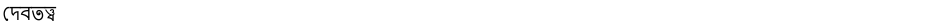
Figure 2. The sample text written by Bankim Chandra Chattopadhyay [3].